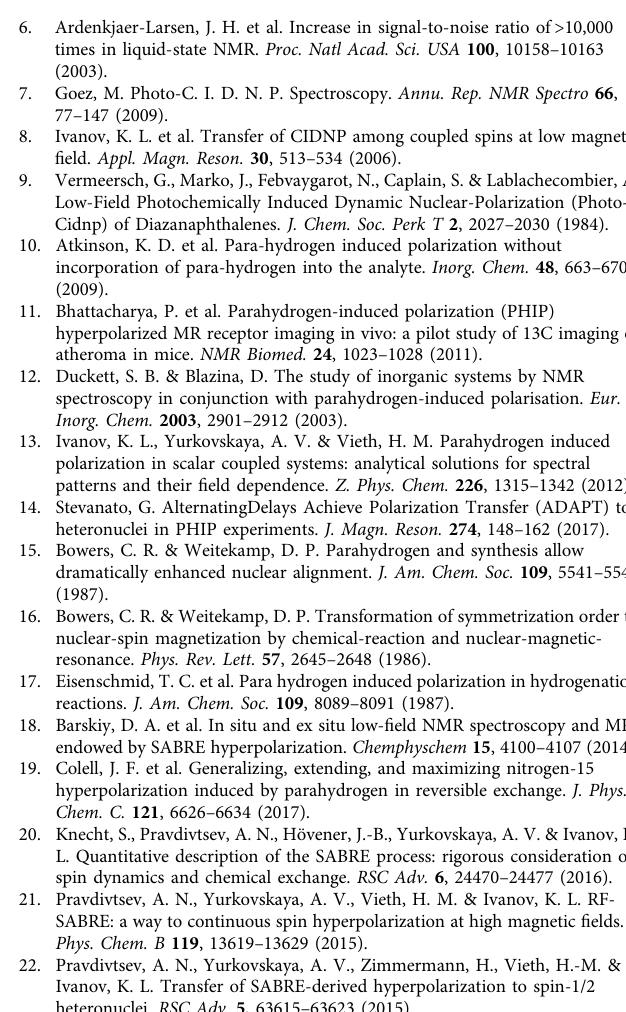
Fig. 5 Delay dynamics of coherent hyperpolarization experiment. a DARTH-EXSY pulse sequence, which uses a pre-saturation bubbling scheme to directly measure exchange of the hyperpolarized hydride. Thermal T 1 from inversion recovery is 888.4 ± 2.7 ms. b DARTH-EXSY signal on ortho-hydrogen weighted with T 1 , yielding an average hydride lifetime of 547 ± 32 ms, making singlet order replentishment signi fi cantly slower than the ligand exchange. DARTH-EXSY spectrum (single shot, inset) with the signals of hyperpolarized ortho-hydrogen (red) indicated. c SHEATH delay dynamics show optimum total signal at τ d = 350 ms (top plot). Calculating the signal per pulse (bottom plot) also shows the effect of slow hydrogen replentishment with the gradually rising signal at long delay